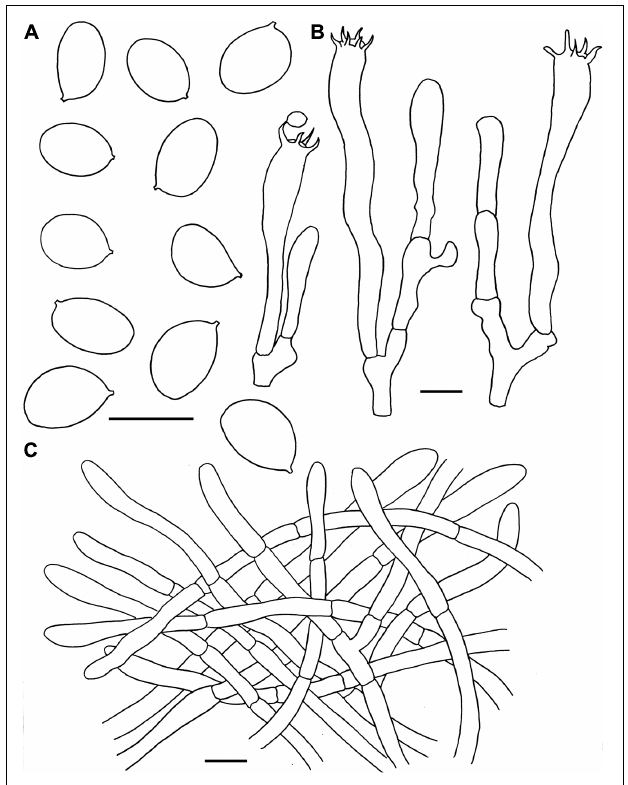
FIGURE 5 | Microscopic features of Craterellus fulviceps (FHMU6553, holotype). (A) Basidiospores. (B) Basidia. (C) Pileipellis. Scale bars = 10 µ m. Drawings by Y.-Z.